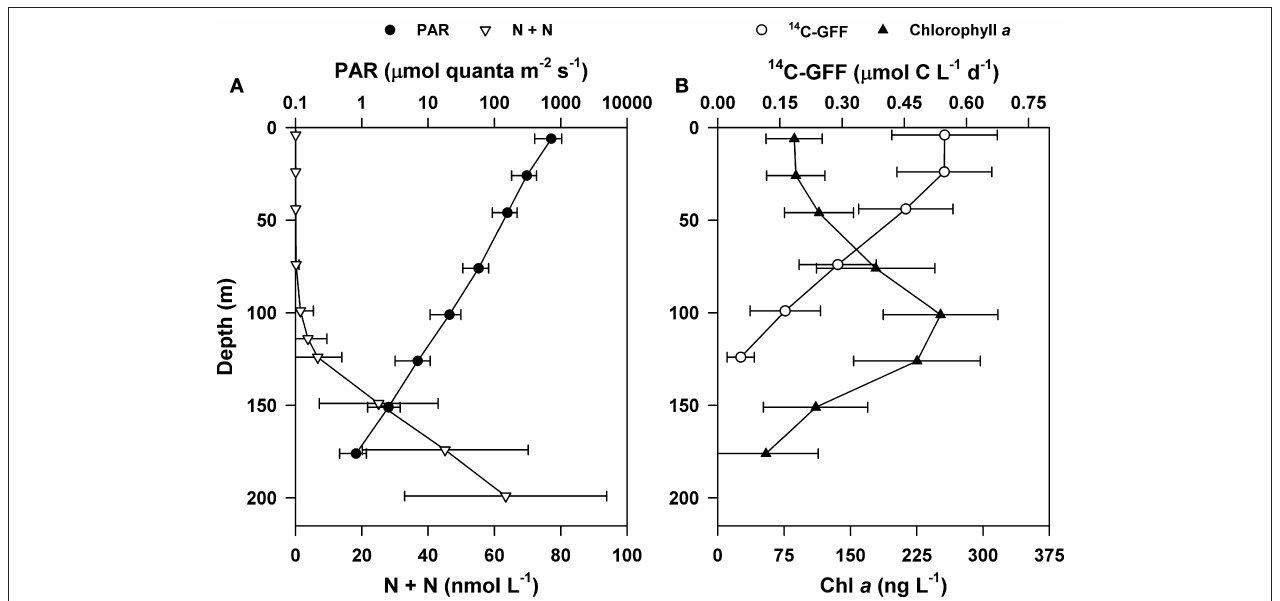
FIGURE 1 | Depth profiles of mean upper ocean properties at Station ALOHA during the period of study (2004–2013). (A) Concentrations of nitrate + nitrite (N + N; open triangles) and flux of photosynthetically active radiation (PAR; closed circles). (B) Concentrations of chlorophyll a (Chl a ; closed triangles) and rates of 14 C-GFF based primary production (open circles). Error bars are ± 1 standard deviation of the time-averaged means.